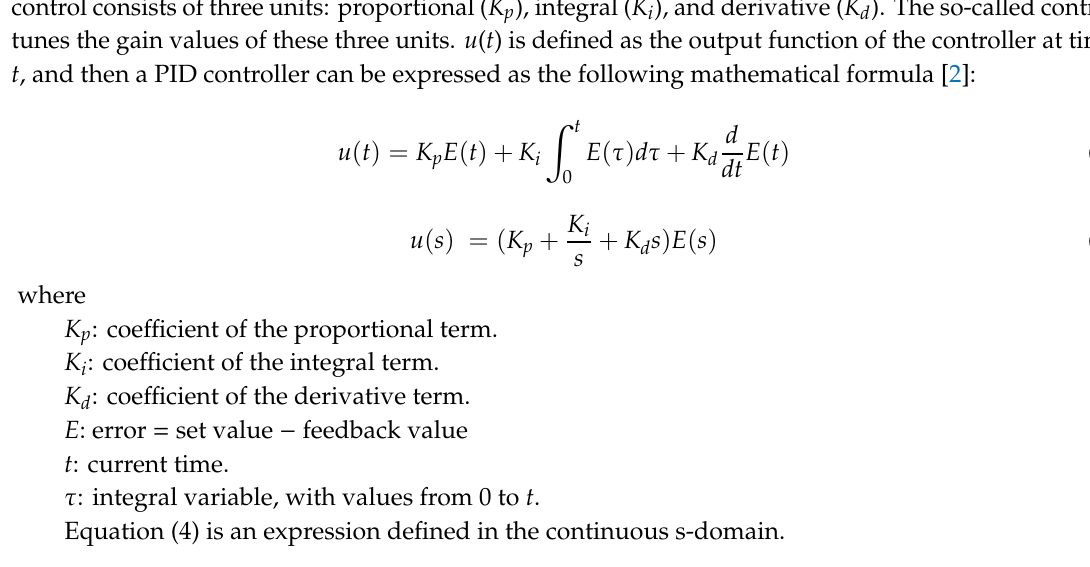
Figure 2. Flowchart modeling the environmental control system.